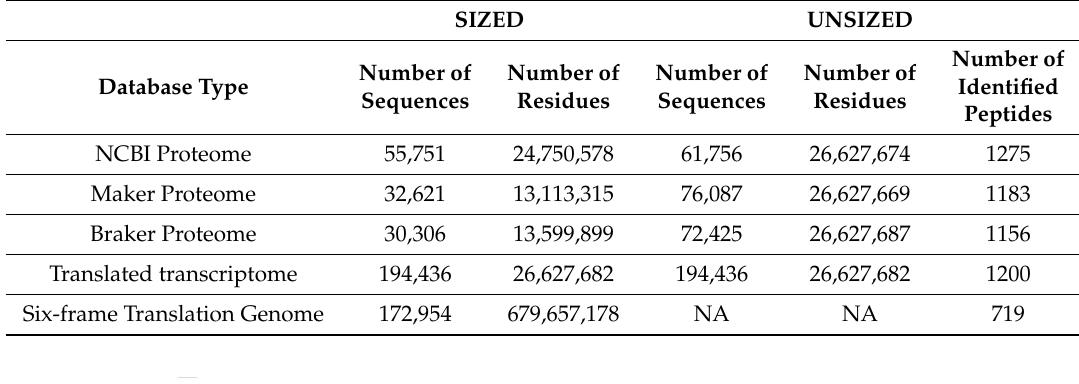
Table 1. The number of residues, sequences, and identified peptides in each sized database. All database sizes include the contaminants database, 125 sequences, 40,028 residues.